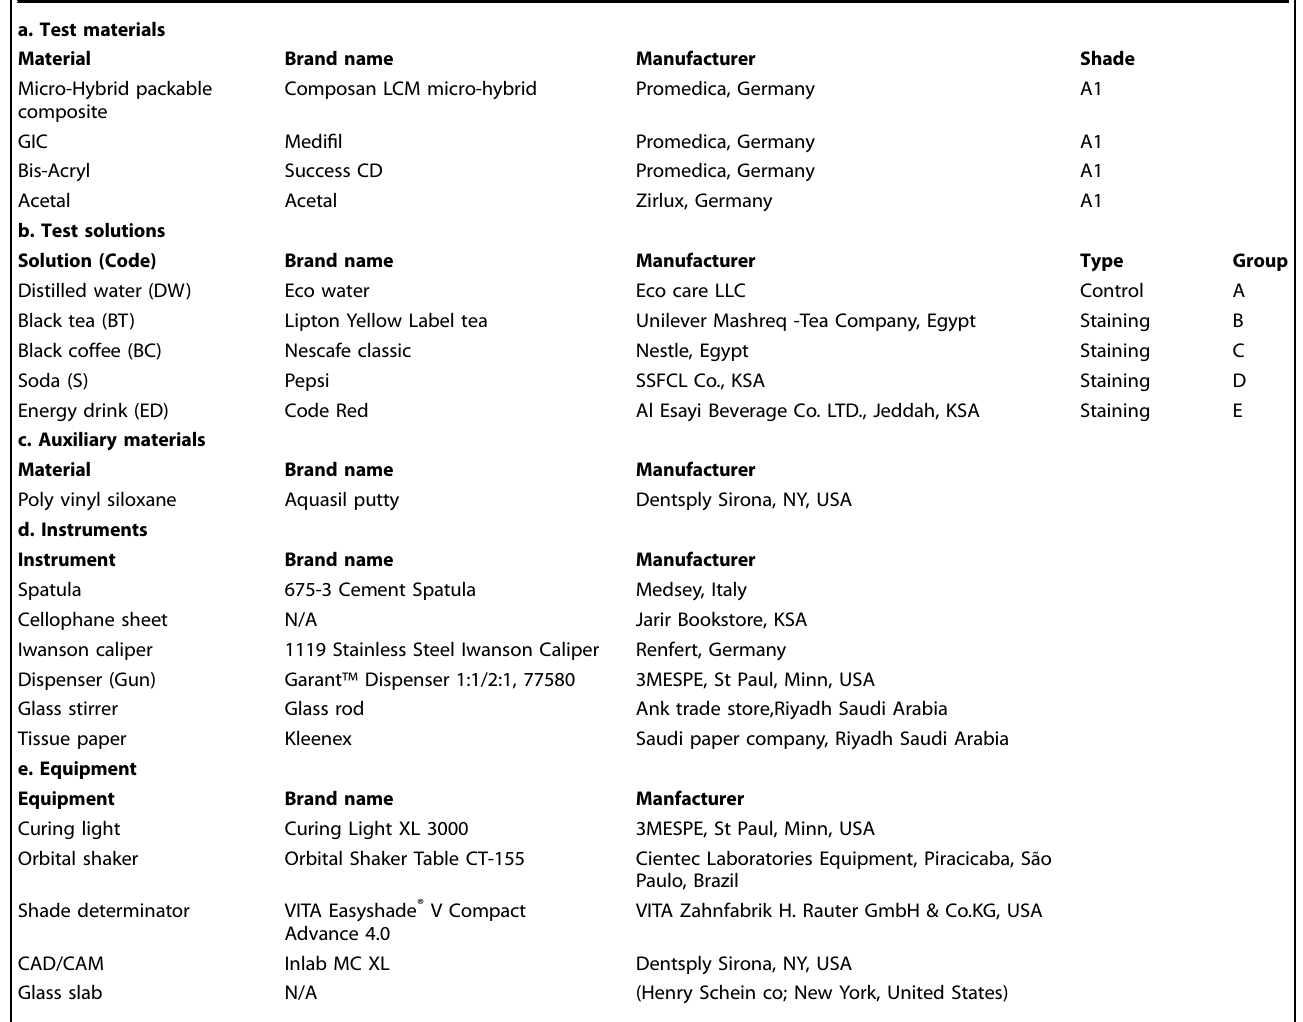
Table 1. Materials, instruments, and equipment used in the